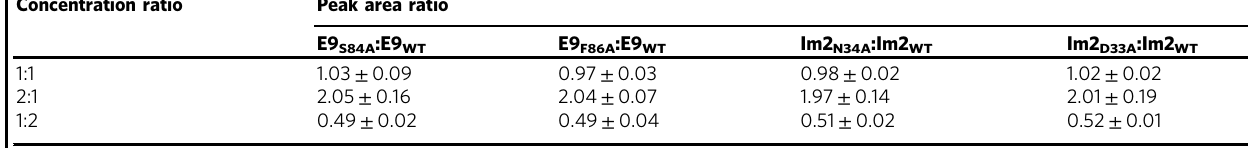
The ratios of peak areas of the mutant and wild-type proteins (Fig. 2) are in excellent agreement with their concentration ratios of 1:1, 2:1, and 1:2 in solution